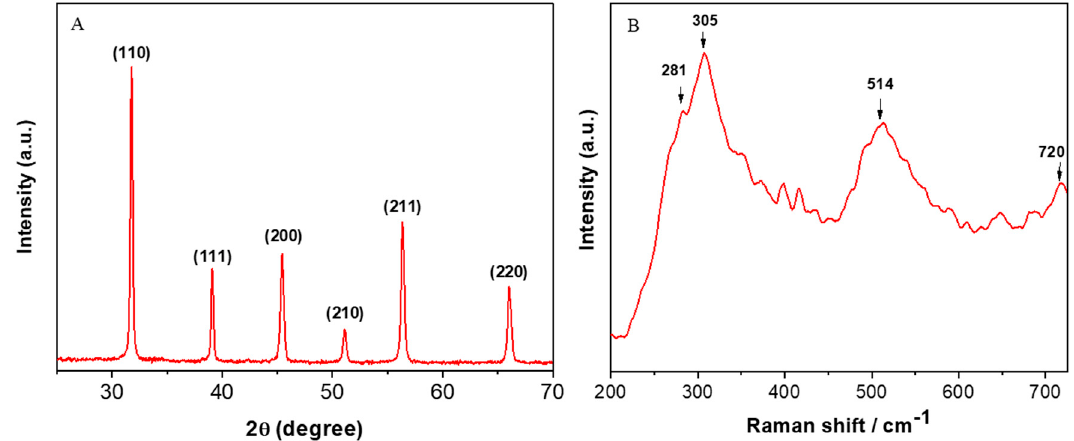
Figure 1. ( A ) XRD and ( B ) Raman spectra of barium titanate nanoparticles (BT NPs). XRD: X-ray Figure 1. ( A )XRD and( B )Raman spectraof bariumtitanatenanoparticles (BTNPs). XRD: X-ray diffraction.